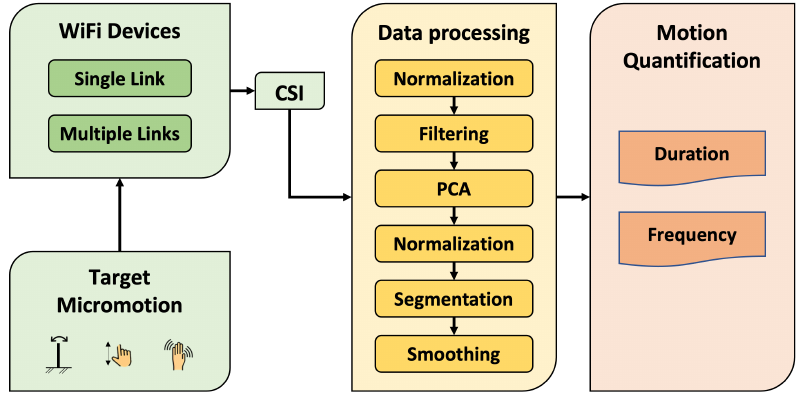
Figure 1. The proposed CSI data processing